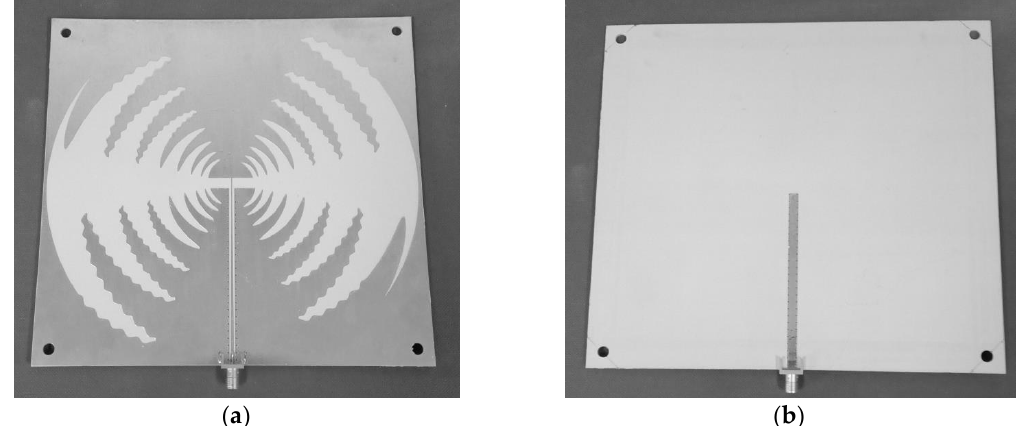
Figure 8. Both sides of the produced sinuous slot antenna with a CPWG excitation: ( a ) top, ( b ) bottom.